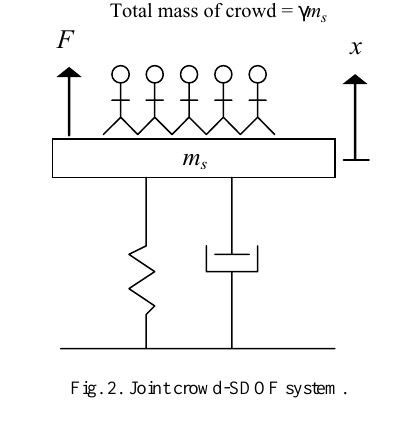
Fig. 2. Joint crowd-SDOF system.